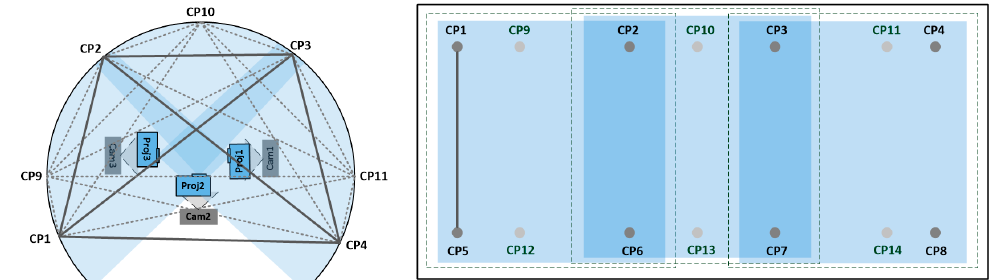
Figure 3. Top view ( left ) and side view ( right ) of the spatial distribution of devices and control points (CPs), and representation of measured distances.